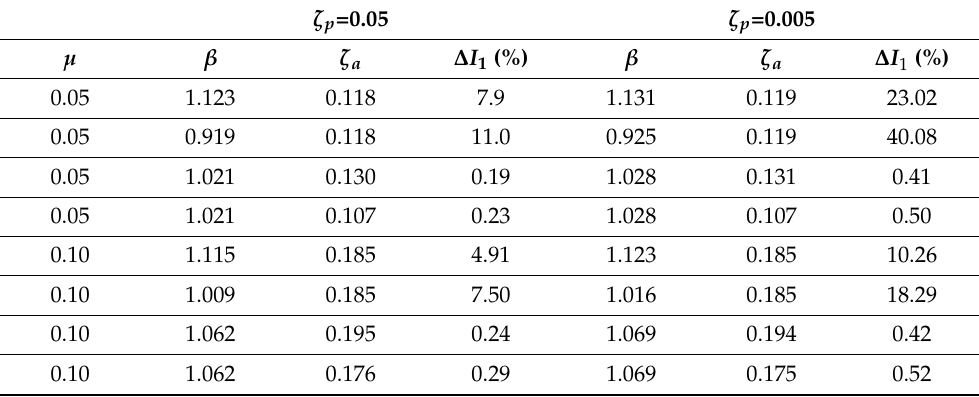
Table 3. Variation in I 1 when β ∗ or ζ ∗ a is varied by ± 10%. ζ p =0.05 ζ p =0.005 µ